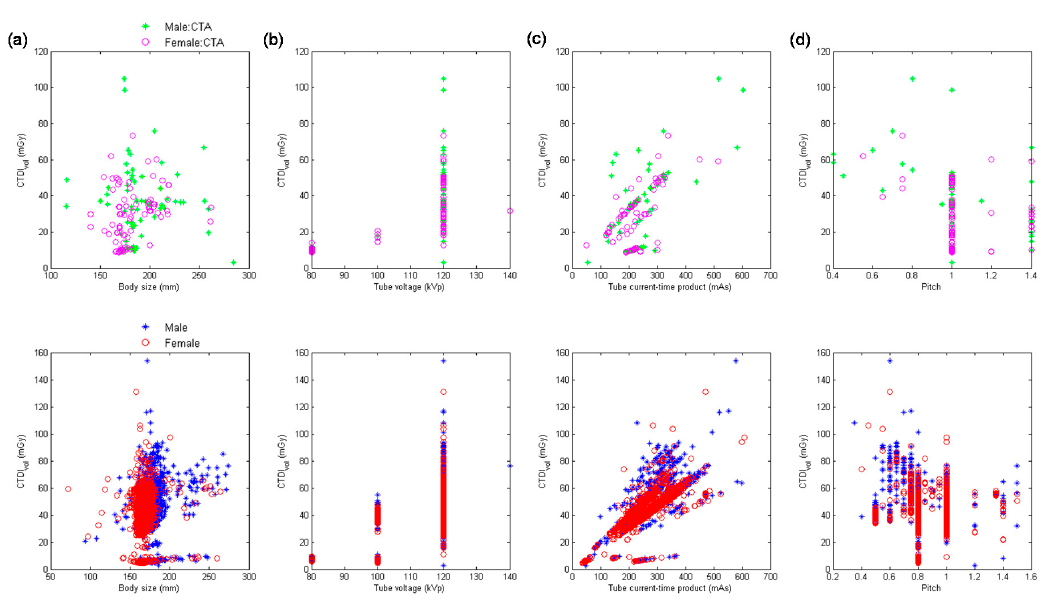
Figure 1. Scatter plots of CTDI vol versus ( a ) body size, ( b ) kVp, ( c ) mAs, and ( d ) pitch for head CTA scans ( upper row) and head scans excluding CT angiography (CTA) ( lower row) performed using 64-slice multi-detector CT units (MDCT 64 ). Diagnostics 2020 , 10 , x FOR PEER REVIEW Table 4. Results of multivariate analysis for the head scans performed using MDCT 64 .